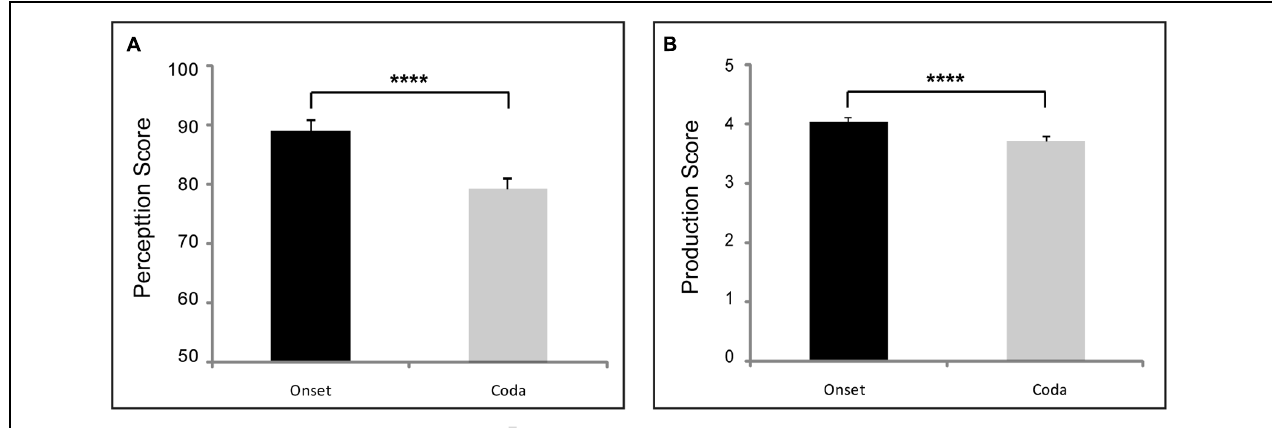
FIGURE 1 | Positional (syllable onset vs. offset) asymmetry in pooled perception (A) and production (B) data of all 38 Chinese subjects. [ ∗∗∗∗ stands for p < 0.0001; error bars for a within-subject design are used (Masson and Loftus,